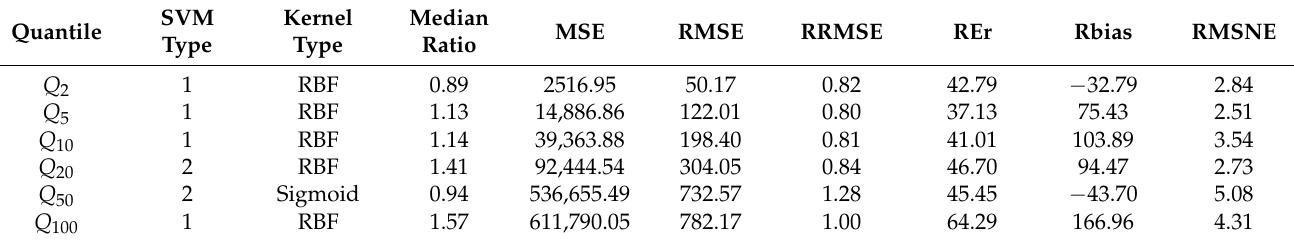
Table 3. Statistical evaluations of the best-performing SVM model for different